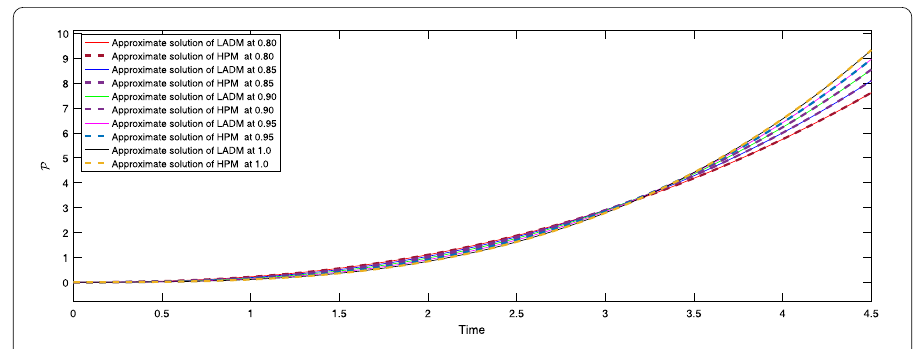
Figure 4 Comparison between the approximate solutions for P of model (3) for various fractional orders up to first three